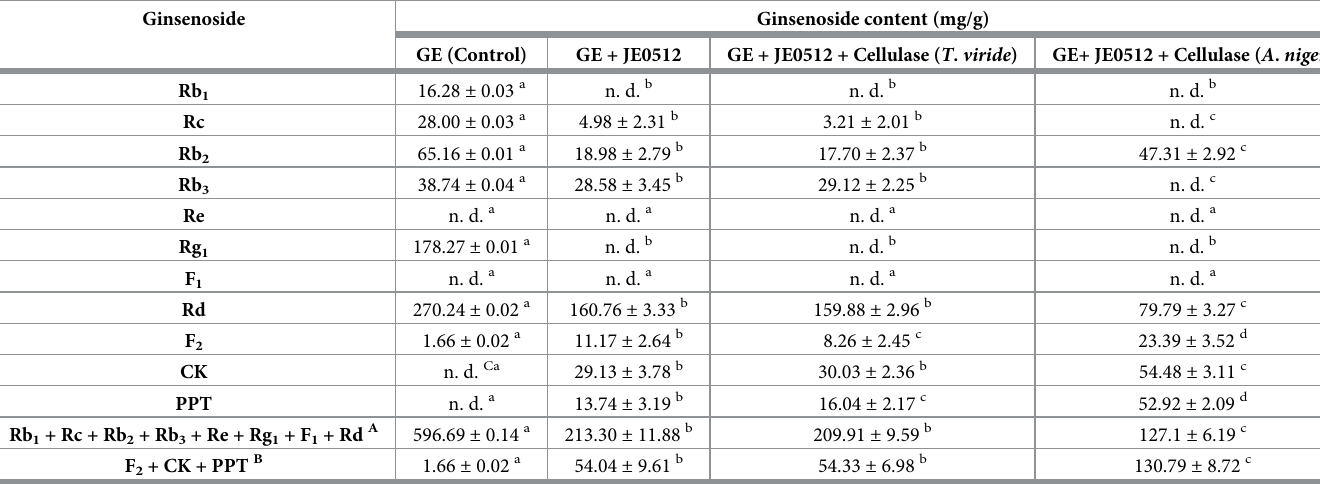
Table 1. The changes in ginsenosides content under different fermentation methods.